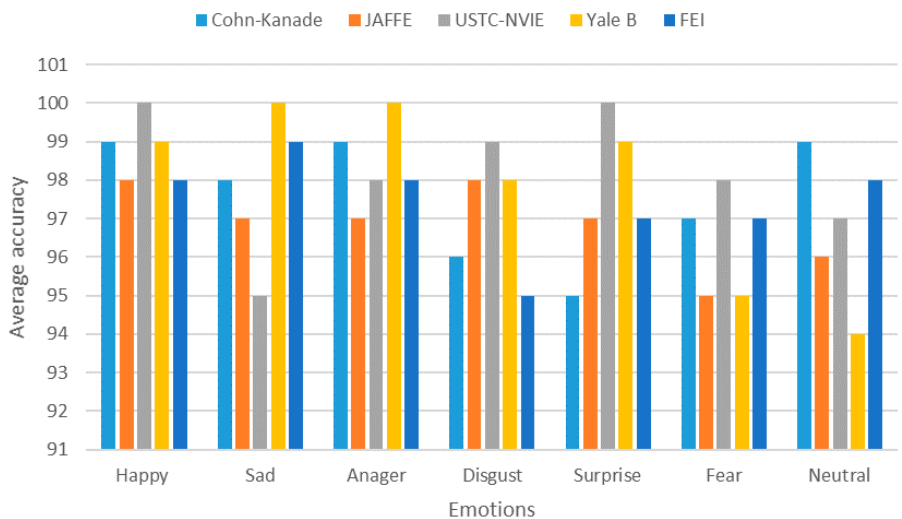
Figure 14. Recognition average accuracy for each dataset. Table 4. Audio base emotion recognition confusion matrix using Emo-DB dataset (unit %).